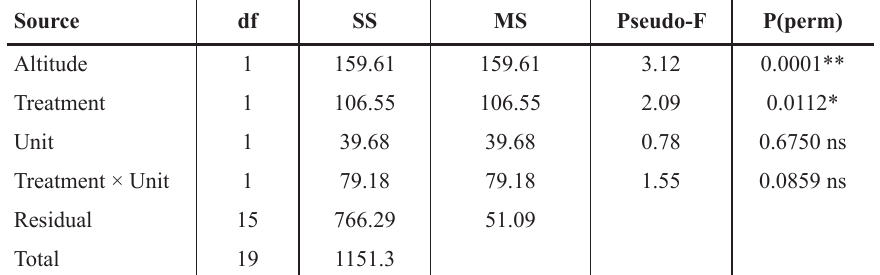
Table 4 – Summary of permutational ANOVA fitted for abundance of alien taxa. Main factors are: Treatment (roadsides vs. 10 m from the roadside), Unit (laurel and thermophilic forest), and their interaction. Altitude is included as covariate. Anaga Rural Park, (Tenerife, Canary Islands). Values followed by ** indicate highly significant differences (p <